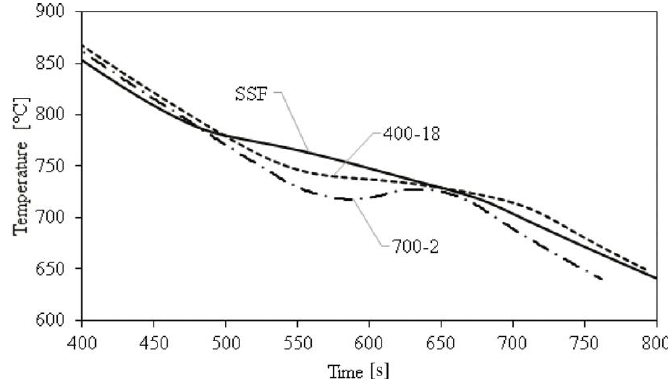
Figure 5. Comparison of temperature profile during the solid-state transformation between traditional and solution strengthened ferritic ductile iron.